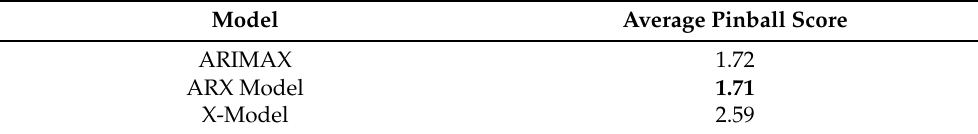
Table 3. Average pinball scores for the three main methods. The best-scoring method is shown in bold.